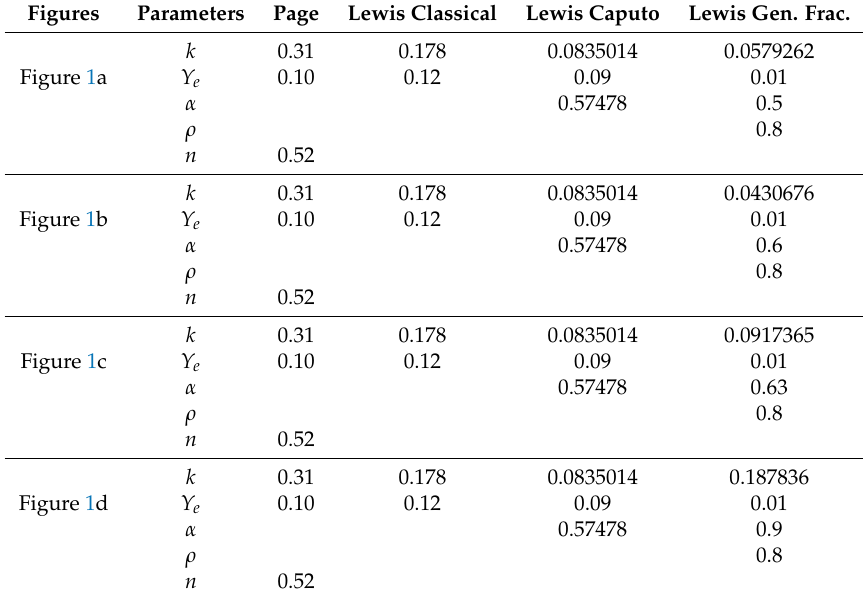
Table 1. Parameter values of models [41].